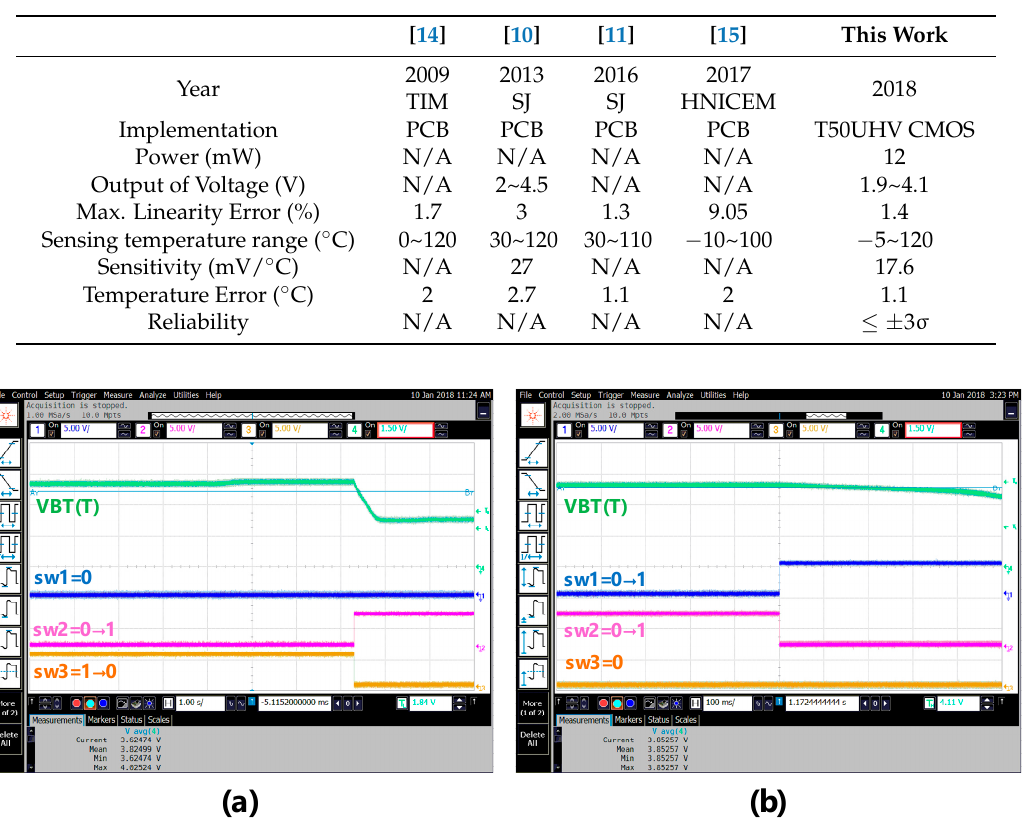
Figure 10. The scenario of three switches when the ambient temperature: ( a ) 35 – 40 °C and ( b ) 80–85 °C.